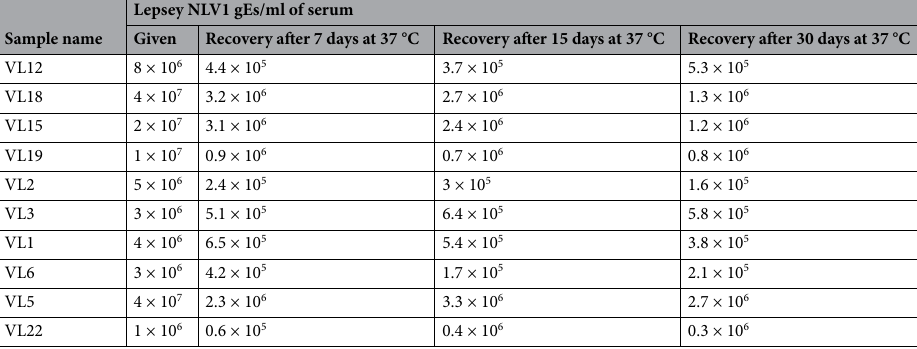
Table 3. Stability of Lepsey NLV1 genome at 37